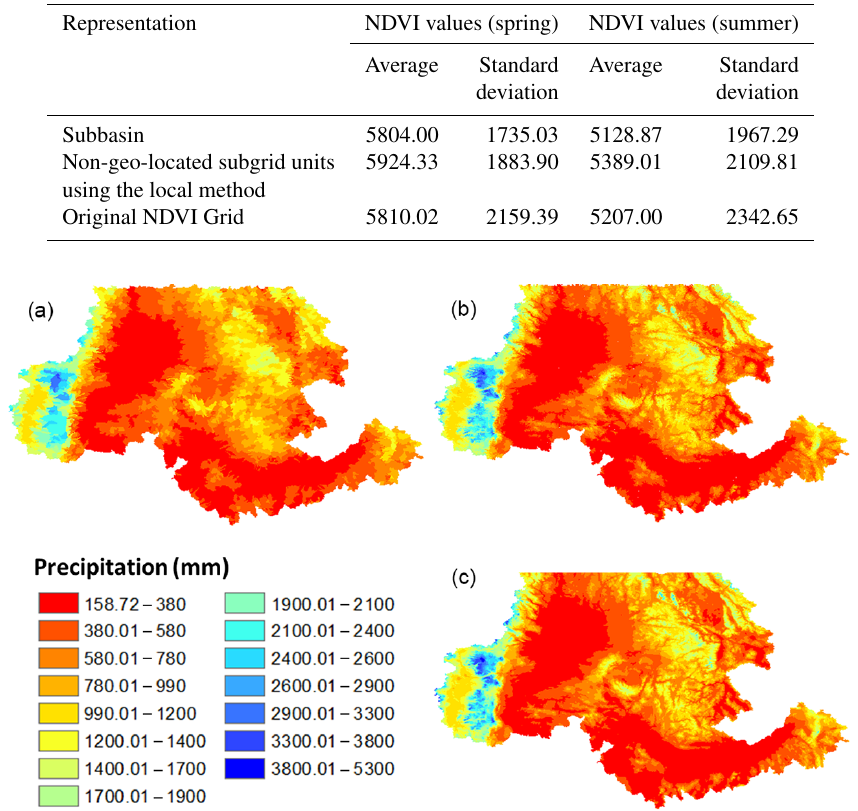
Figure 13. PRISM 30-year normal precipitation represented using the subbasins (a) and non-geo-located SUs from the local method using 3% area threshold (b) compared to those of the original PRISM grids (c) . The Canadian territory of the study area is not represented in the PRISM